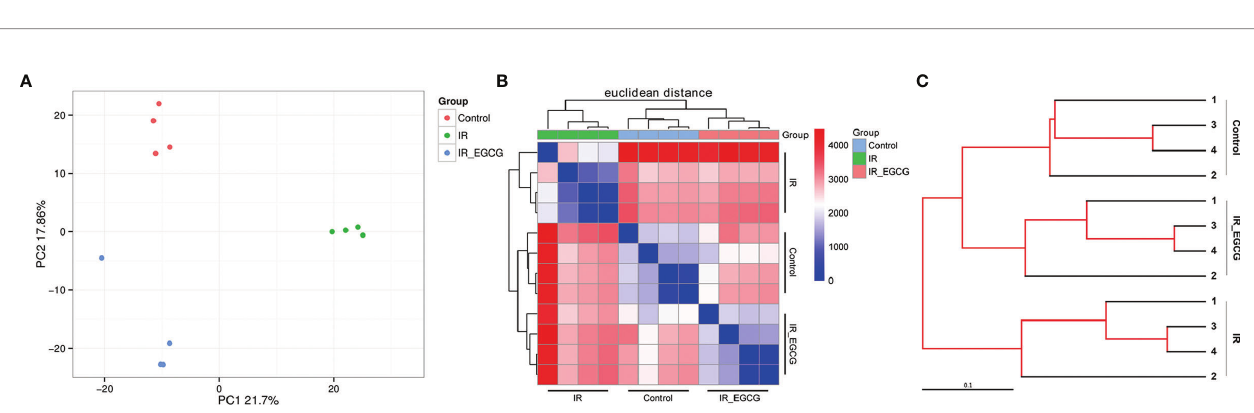
FIGURE 4 | EGCG treatment restores the composition of the intestinal fl ora in the irradiated mice. (A) Differences in gut microbiota composition in vehicle/EGCG- treated mice after the exposure to 9 Gy TBI assessed by principal coordination analysis (PCoA). (B) Heatmap calculated from the Euclidean distance of the fecal samples of all groups. (C) UPGMA tree of the gut microbiota from vehicle/EGCG-treated mice after the exposure to 9 Gy